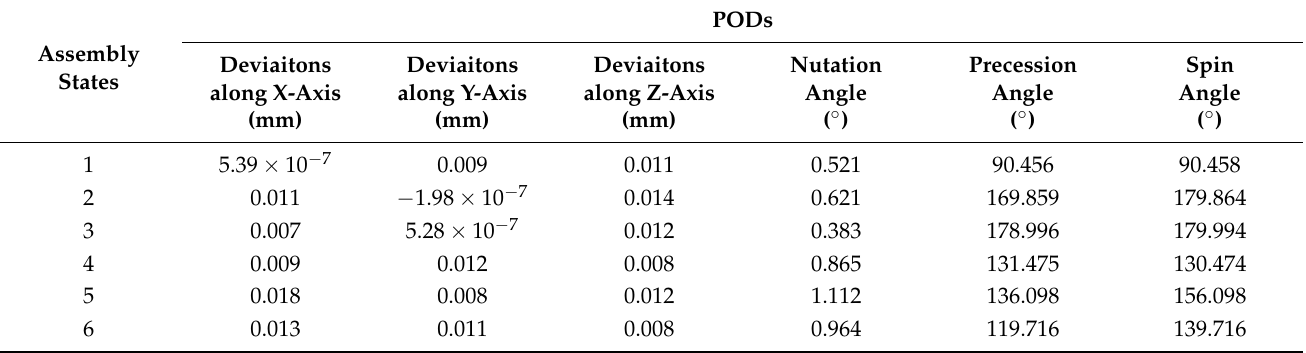
Figure 11. Determined contact points of the six assembly states. The three contact points on the main mating plane are red, the two contacts point on the first auxiliary mating plane are green, and the contact point on the second auxiliary mating plane is yellow. Table 4. Acquired position and orientation deviations (PODs) of the assembly with three mating planes.